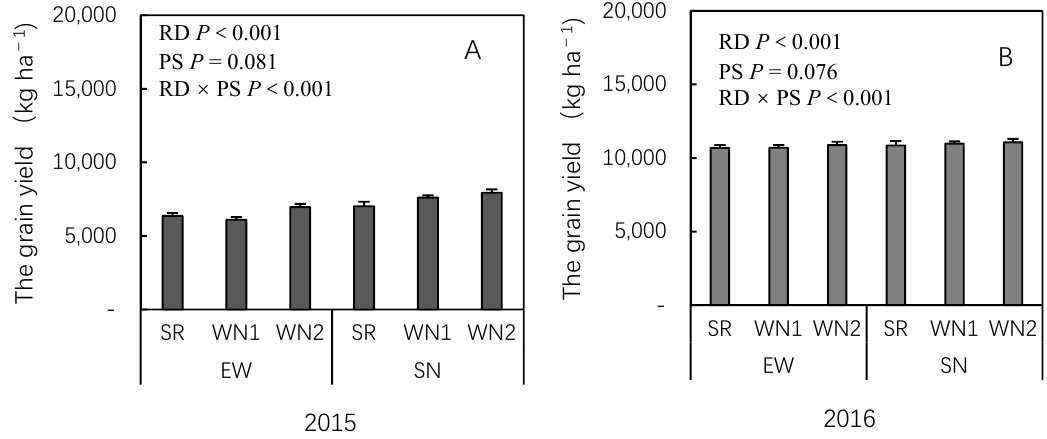
Figure 8. Grain yield of maize under two row directions (RD) and three plant spacings (PS) in 2015 ( A ) and 2016 ( B ) (EW and SN indicate row direction of east to west and south to north, respectively. SR indicates single rows spaced at 65 cm; WN1 indicates 40 cm twin rows spaced at 90 cm between the paired rows of narrow-wide rows; and WN2 indicates 40 cm twin rows, spaced at 160 cm between the paired rows of narrow-wide rows). Bars denote the SE of the mean ( n = 3).